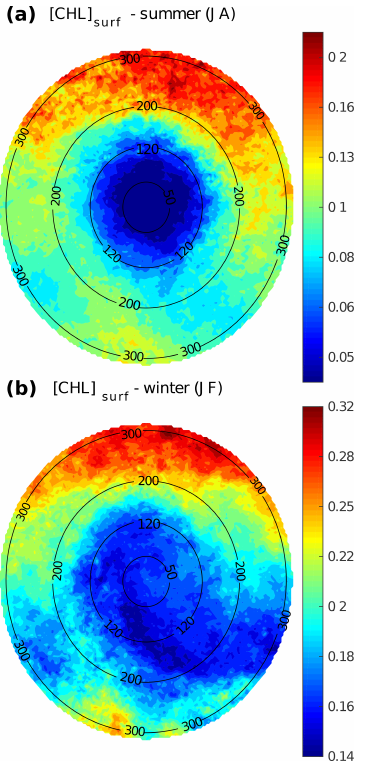
Figure 3. LCE composite images of [Chl] surf derived from Aqua- MODIS for the (a) summer and (b) winter seasons. Black circles indicate the radius in